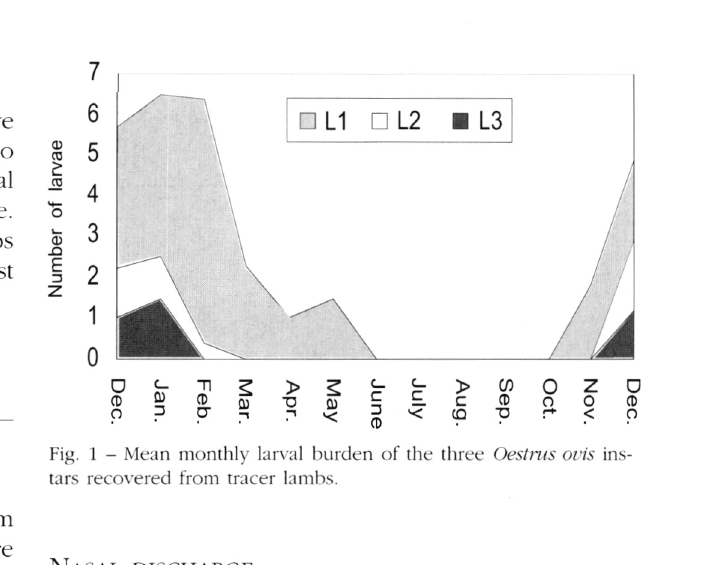
Fig. 1 - Mean monthly larval burden of the three Oestrus ovis ins­ tars recovered from tracer lambs.